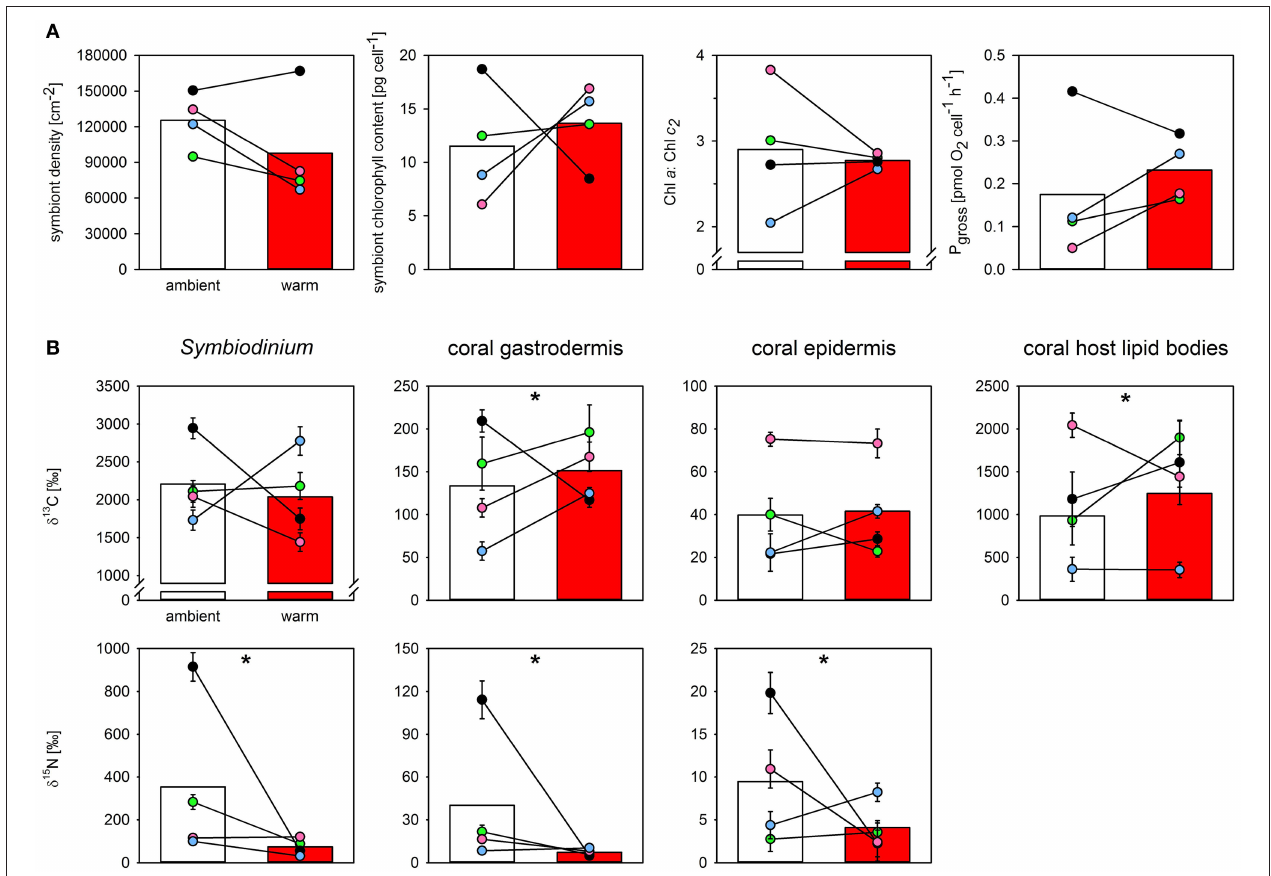
FIGURE 3 | The effect of acclimation temperature on the physiological function and the carbon and nitrogen assimilation of Pocillopora damicornis at the end of 7-days of heat stress. Shown are the effect of acclimation temperature on (A) final symbiont density, symbiont chlorophyll content, Chl a :Chl c 2 ratio, and symbiont oxygen production (from left to right), and (B) carbon and nitrate assimilation (top and bottom row, respectively) in different compartments of the oral coenosarc tissue, as assessed by NanoSIMS. Bars represent mean response of ambient- (white) and warm-acclimated (red) corals with the individual colony performance indicated as colored dots (paired design; blue, green, magenta, black for colonies 1–4, respectively). NanoSIMS data represent means ± SE of imaged symbionts ( N = 28–38 per sample), surrounding gastrodermal and epidermal area ( N = 11–17), and host lipid bodies contained within the imaged gastrodermal area ( N = 5–45).